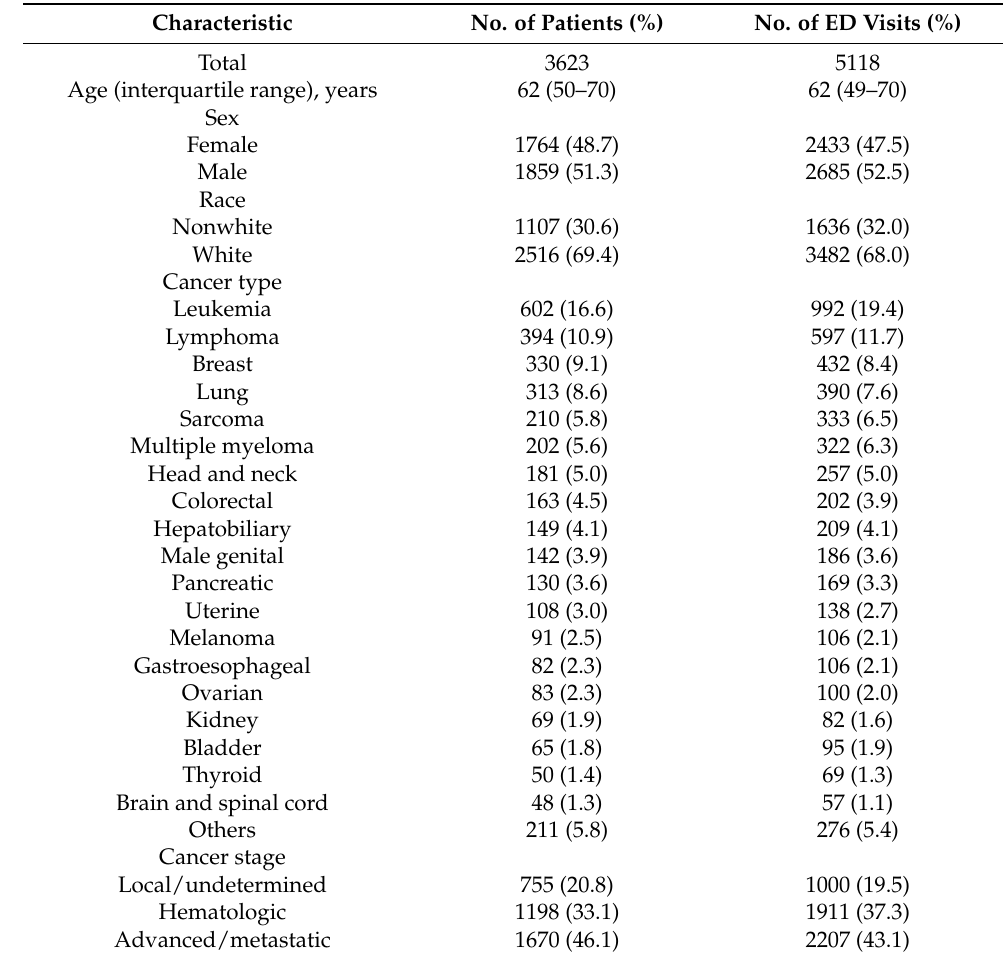
Table 1. Demographic and clinical characteristics of cancer patients who visited the emergency department (ED) with suspected infection during the period